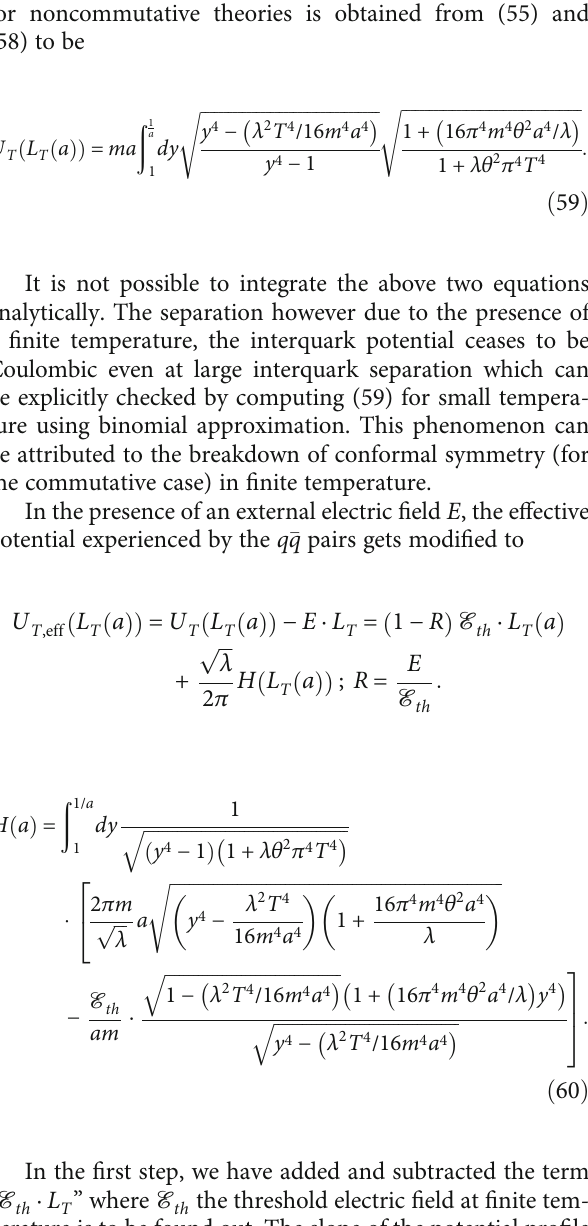
1 ffiffiffiffiffiffiffiffiffiffiffiffiffiffiffiffiffiffiffiffiffiffiffiffi